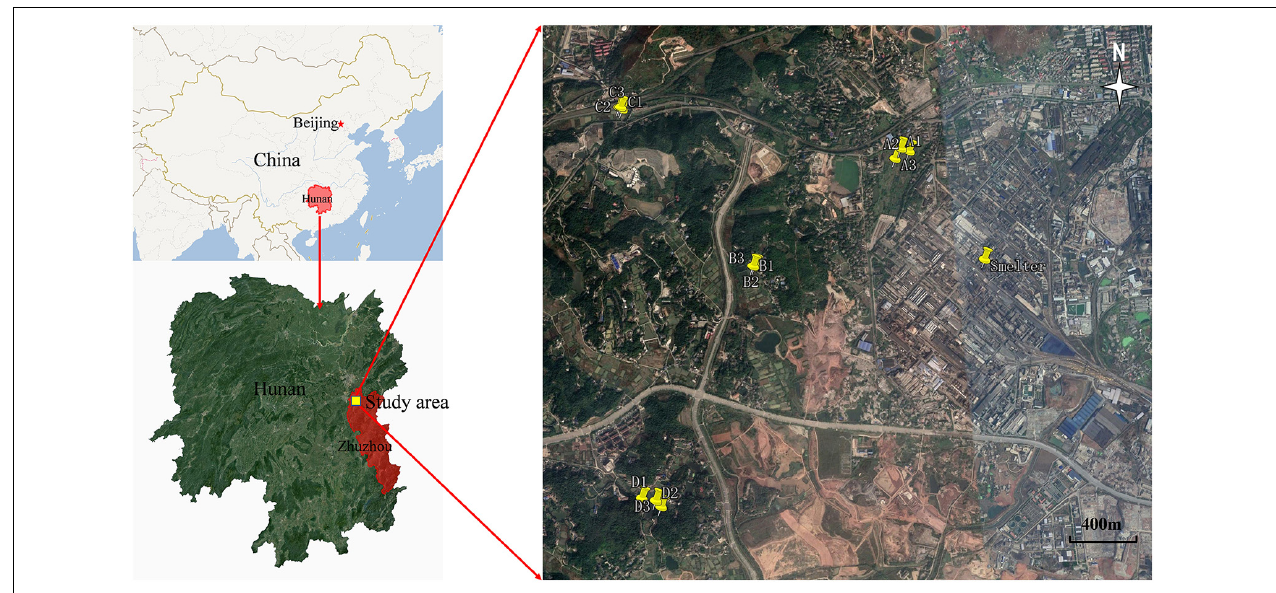
FIGURE 1 | Map indicating the location of four test